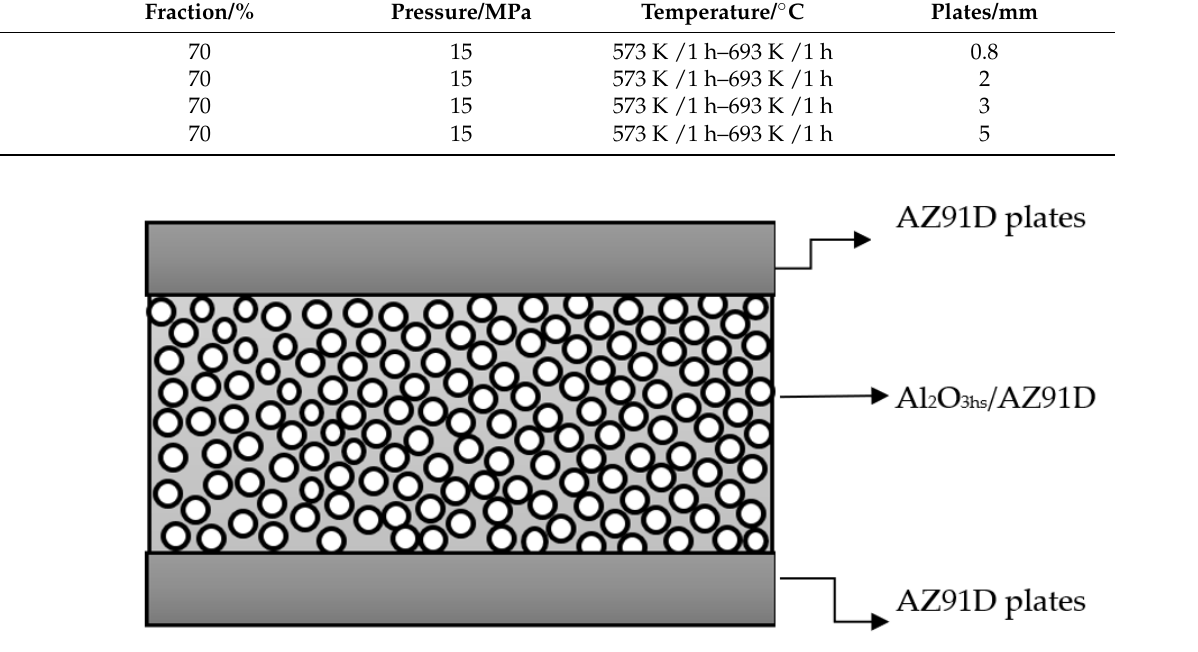
Figure 12. Schematic diagram of the sandwiched magnesium matrix syntactic foams.